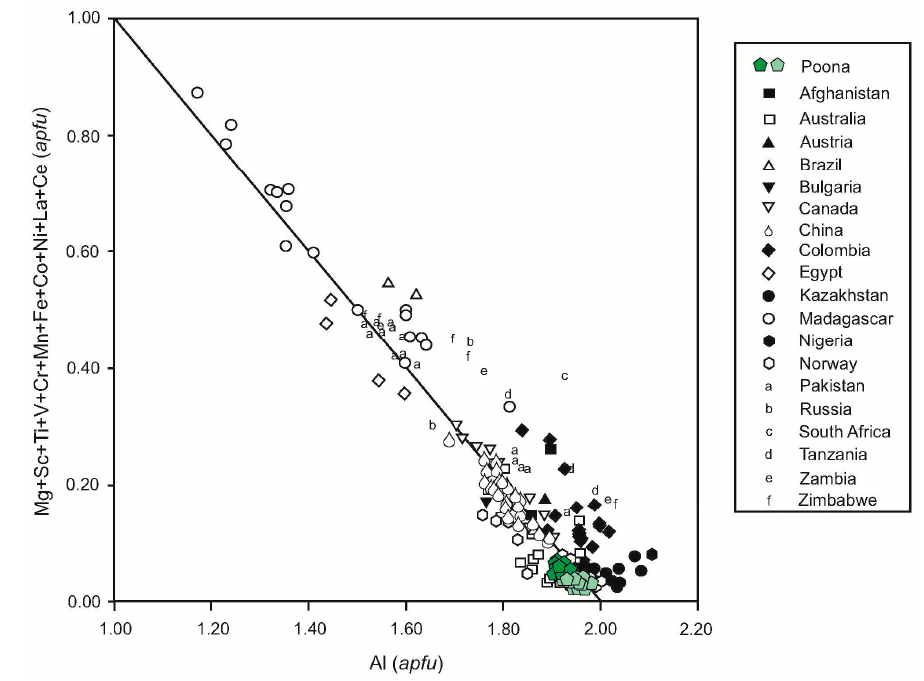
Figure 5. Al versus the sum of other Y-site cations, in atoms per formula unit. The Poona emerald compositions are superimposed on worldwide emerald data compiled from the literature in [6,7,25,27]. The dark and light green hexagons correspond to emerald vs. beryl compositions in the Poona samples.